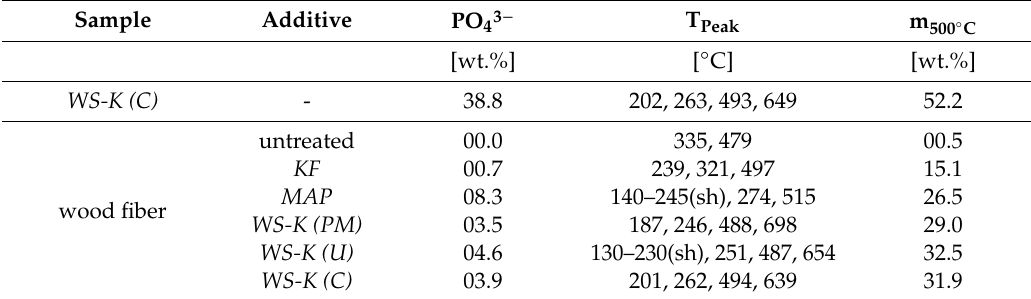
Figure 6. Thermal degradation behavior of wood fibers with different additives measured with TGA under air atmosphere, additive content 10 wt.%. Table 4. Results from TGA measurements.